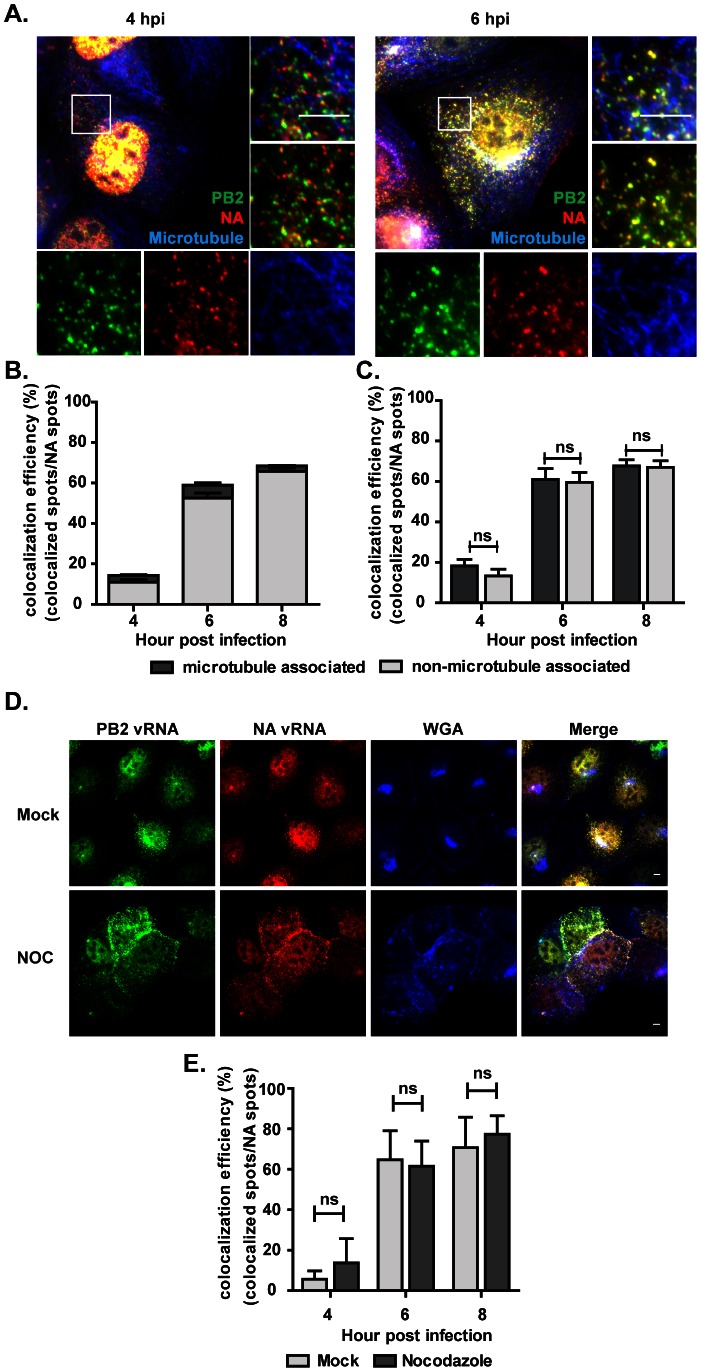
The colocalization of PB2 and NA vRNAs is independent of microtubules.(A&B) MDCK cells infected with PR8 virus at MOI = 5 were subjected to immunofluorescence staining of the microtubules (blue) and two-color smFISH using Cy5- or Cy3-fluorophore labeled probes against the PB2 vRNAs (green) or the NA vRNAs (red), respectively. (A) Two-dimensional merged images of the microtubules, PB2 and NA vRNAs are shown for cells at 4 and 6 hpi (upper left image in each panel). The enlarged image of the boxed region is shown on the upper right corner; the enlarged images taken in each channel (bottom), and the merged image between the PB2 and NA vRNA spots are also shown (middle, right). Scale bar = 10 µm. (B) Quantification of the colocalization between PB2 and NA vRNAs is shown. The proportions of colocalized vRNAs associated with microtubules are represented in dark gray and the colocalized vRNAs that are not colocalized with microtubules are denoted in light gray. The percentages of colocalized vRNAs associated with microtubules are 24.5% at 4 hpi, 10.3% at 6hpi and 4.1% at 8hpi. Error bars represent standard deviation. (C) Quantification of the colocalization between PB2 and NA vRNAs that were associated with microtubules (dark gray) or not associated with microtubules (light gray). Error bars represent standard deviations. ns: un-paired t-test no significance. (D&E) MDCK cells were infected with PR8 virus at MOI = 5 and treated with nocodazole (NOC) at 1.5 hpi. (D) The treated cells were fixed at 8 hpi for smFISH analysis. Images of the Cy5 fluorescence (PB2 vRNAs), Cy3 fluorescence (NA vRNAs), Alexa 488 signal (cell membrane), and a merged image are shown for mock treated or NOC treated cells (Maximum Intensity Projections). Alexa-488 conjugated wheat germ agglutinin (WGA) stains the plasma membrane and Golgi apparatus in the cells. Scale bar = 5 µm. (E) Colocalization efficiency of PB2 and NA vRNAs in mock treated and NOC treated cells are shown. For each experimental condition, more than 50 cells were analyzed. Error bars denote standard deviation. ns: un-paired t-test no significance.